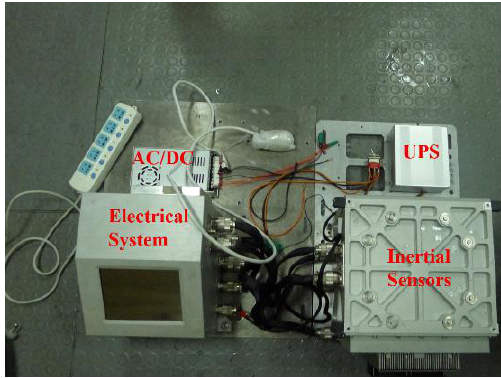
Figure 13. The ship mounted strapdown inertial navigation system in this experiment.